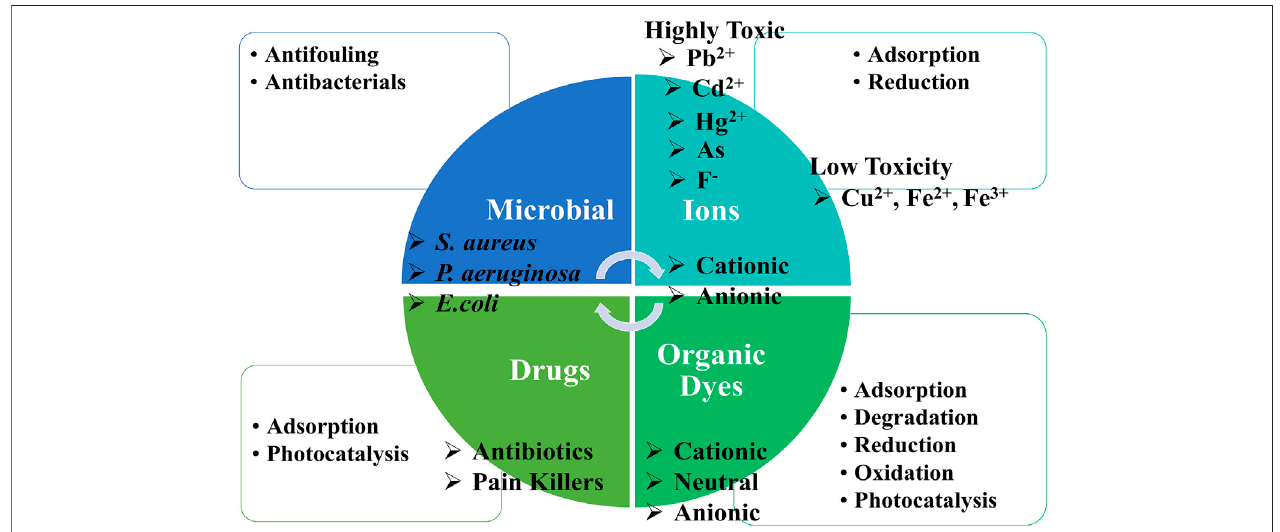
FIGURE 1 | Common pollutants present in water and the removal methods toward each contaminant.